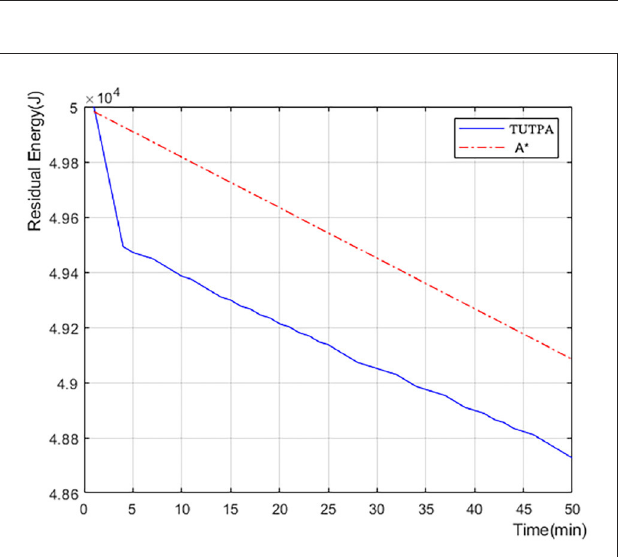
FIGURE13 The remaining power of a single UAV after performing data acquisition on